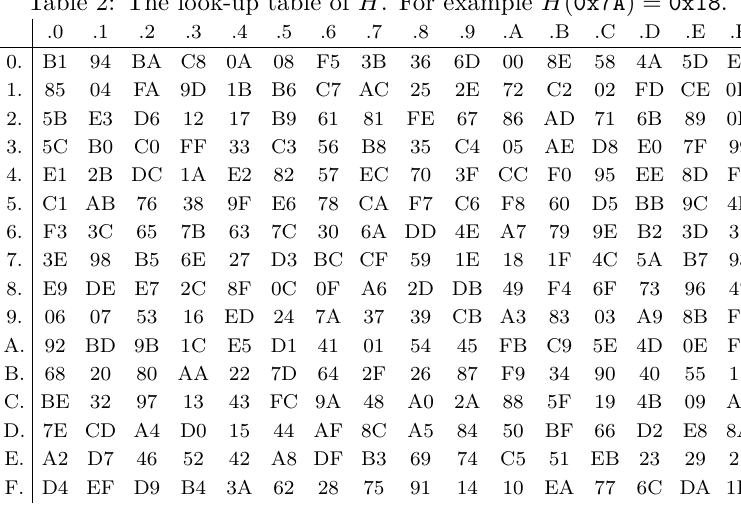
Table 2: The look-up table of 𝐻 . For example 𝐻 ( 0x7A ) = 0x18 . .0 .1 .2 .3 .4 .5